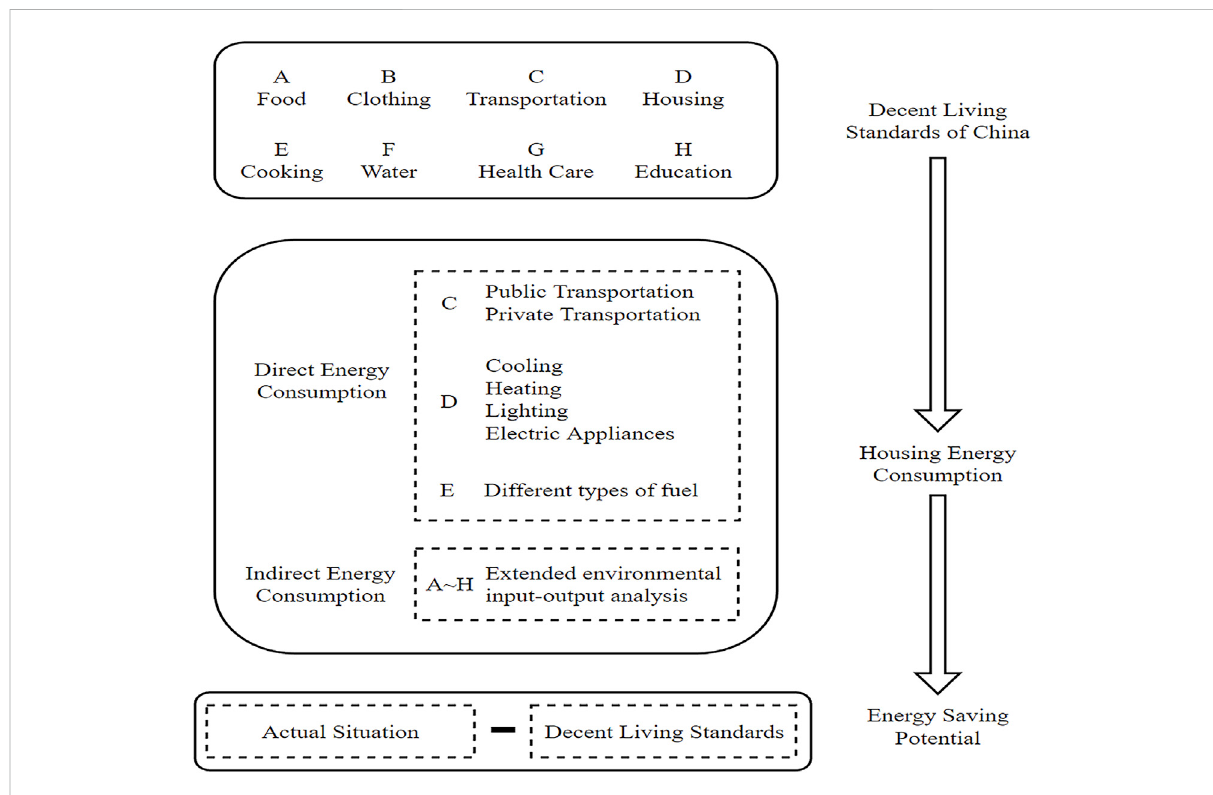
FIGURE 1 Methodological